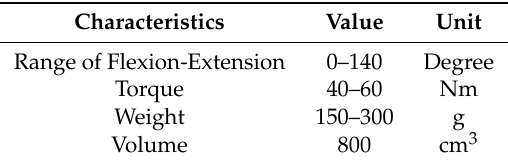
Table 1. Characteristics of an Active Elbow